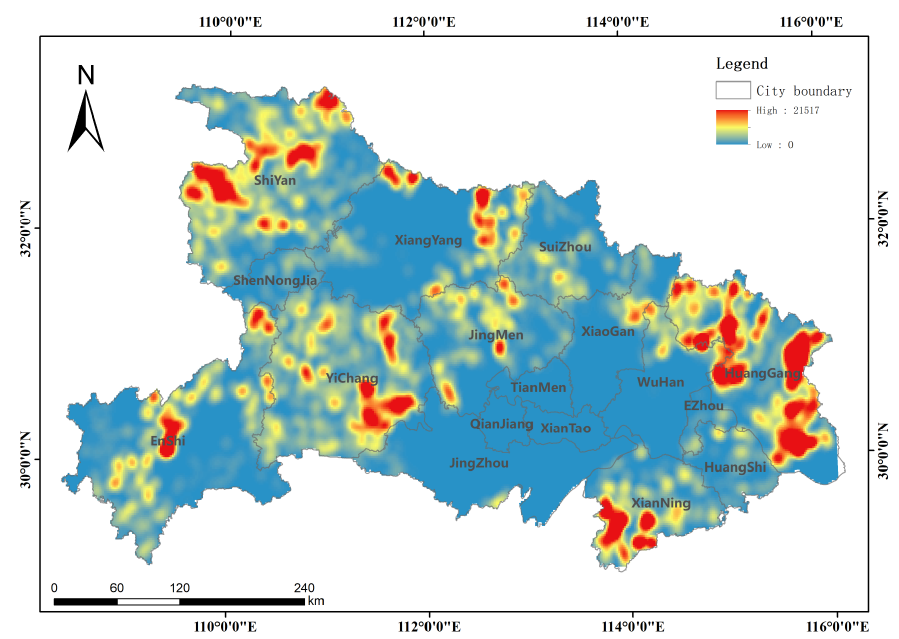
Figure 4. Heat Map of Flash Flood Disasters.